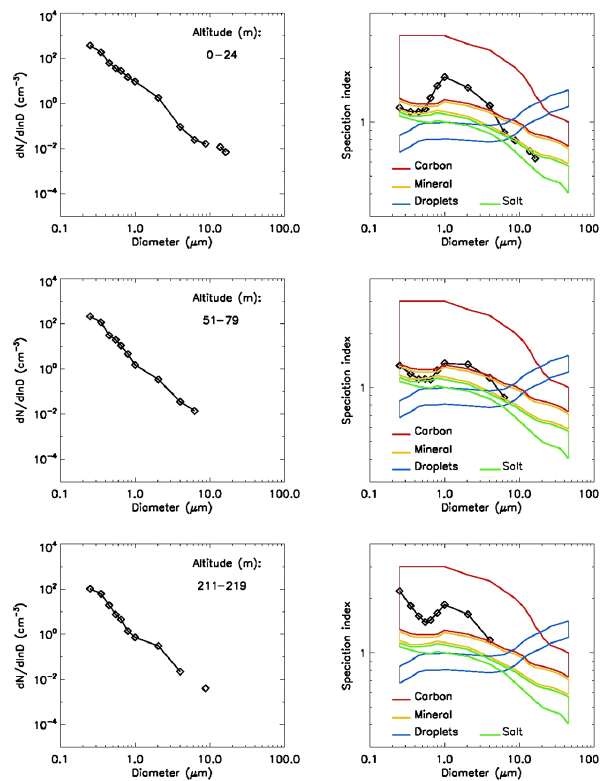
Figure 6. Size distribution and typology at three altitudes during a flight under a tethered balloon in Vienna on 11 April 2013 at 11:00UT; the uncertainties for concentrations are the same as in Fig. 5; the sizes of the dots represent the error bars for the typol- ogy. A mixture of carbonaceous and mineral particles is detected from the ground, mineral particles dominate for the concentration enhancement at ∼ 80m, probably emitted from the construction of a nearby tower; above 200m, carbonaceous particles dominate only.